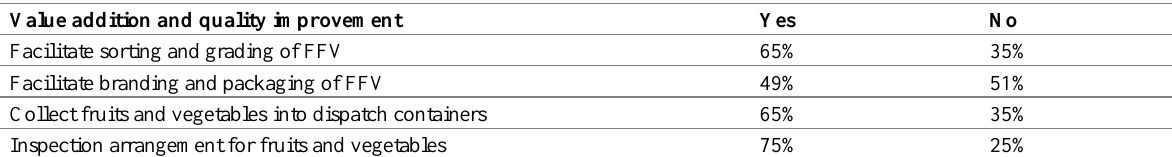
Table 4: Summary of Value Addition and Quality Improvement for FFVs